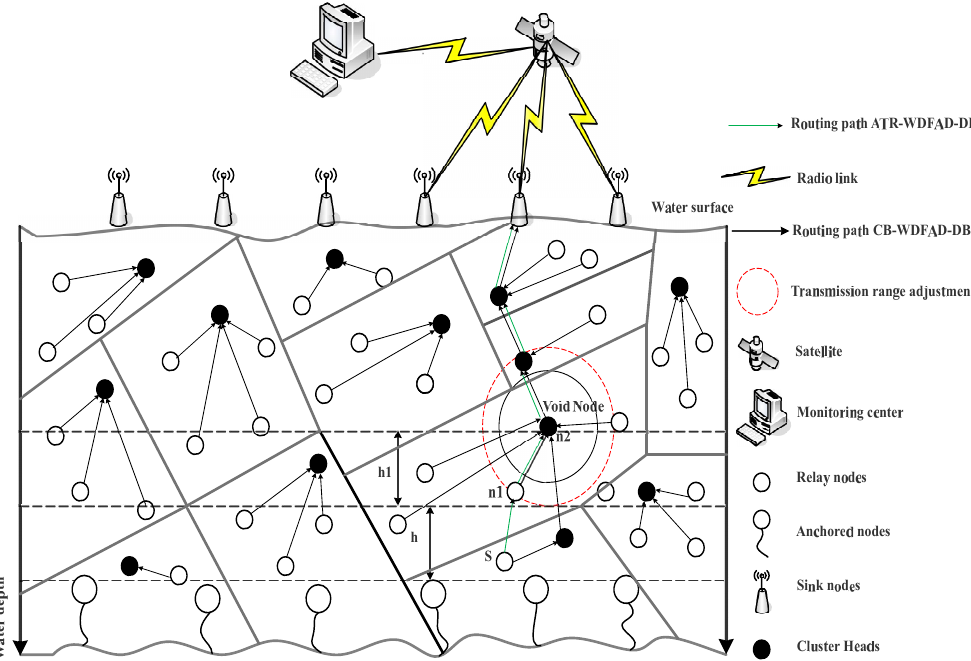
Figure 2. Proposed system model illustrating Adaptive transmission range in WDFAD-Depth-Based Routing (DBR) and Cluster-based WDFAD-DBR